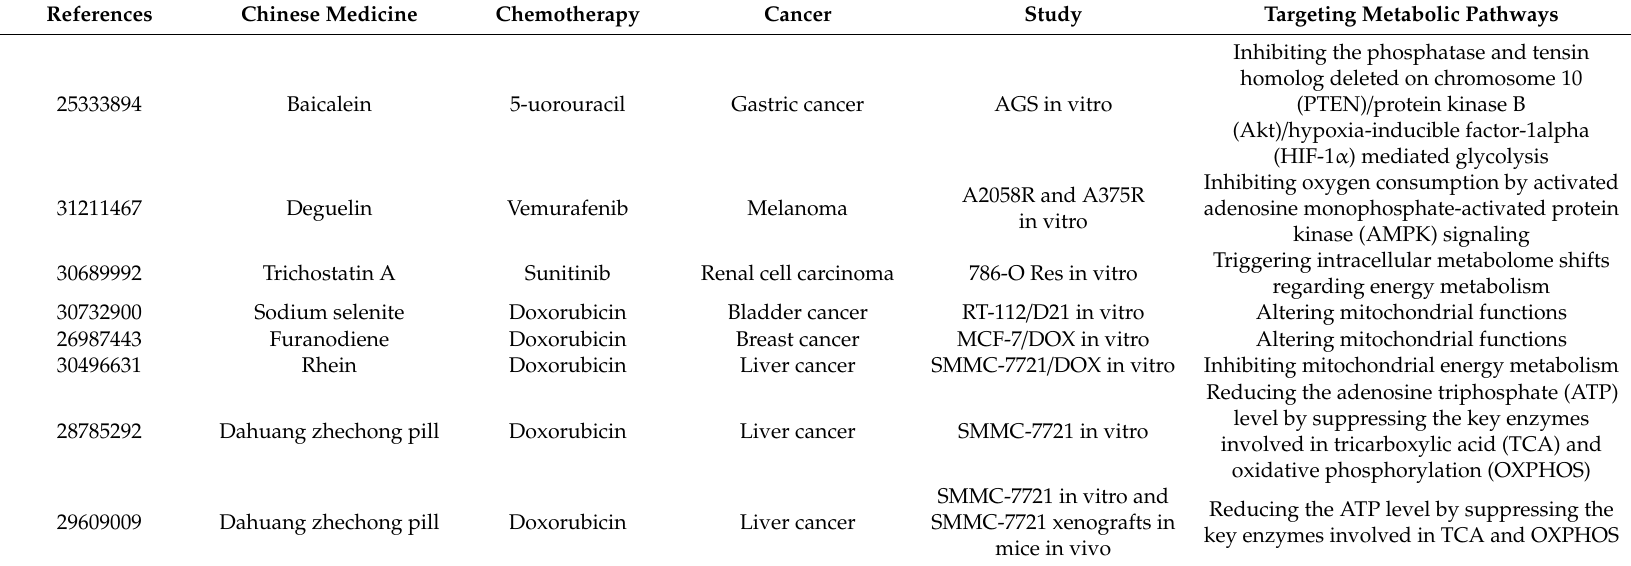
Table 1. The summary of recent studies on traditional Chinese medicine in combination of chemotherapeutics for overcoming resistance targeting glucose and energy